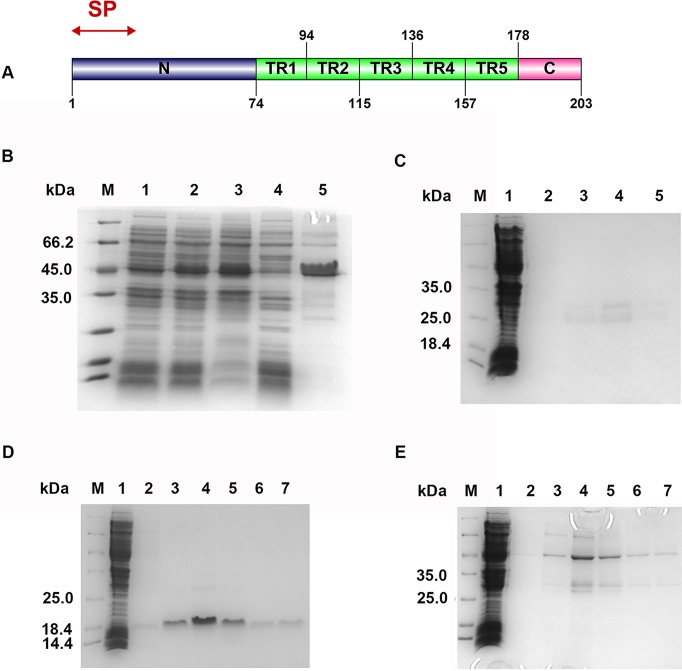
The predicted molecular properties of Cs1 protein and expression of different fragments of Cs1.(A) The predicted molecular properties of Cs1 protein. SP: signal peptide; N: N-terminus; TR: tandem repeat; C: C- terminus. (B) Expression and purification of rCs1 by 12% SDS-PAGE. Lane 1, BL21(DE3) cells containing the recombinant pET28α-Cs1 homolog without IPTG induction; lane 2, BL21(DE3) cells containing the recombinant pET28α-Cs1 homolog with IPTG induction; lane 3, supernatant of lysed BL21(DE3) cells containing the recombinant pET28α-Cs1 homolog with IPTG induction; lane 4, pellet of lysed BL21(DE3) cells containing the recombinant pET28α-Cs1 homolog with IPTG induction; lane 5, the recombinant protein purified by affinity purification. (C) Expression and purification of rCs1TR. Lanes 1–5, different fractions of purified rCs1TR protein. (D) Expression and purification of rCs1N. Lanes 1–7, different fractions of purified rCs1N. (E) Expression and purification of rCs1C+TR. Lanes 1–7, different fractions of purified rCs1C+TR. Lane M in (B)-(E) shows molecular mass standards.